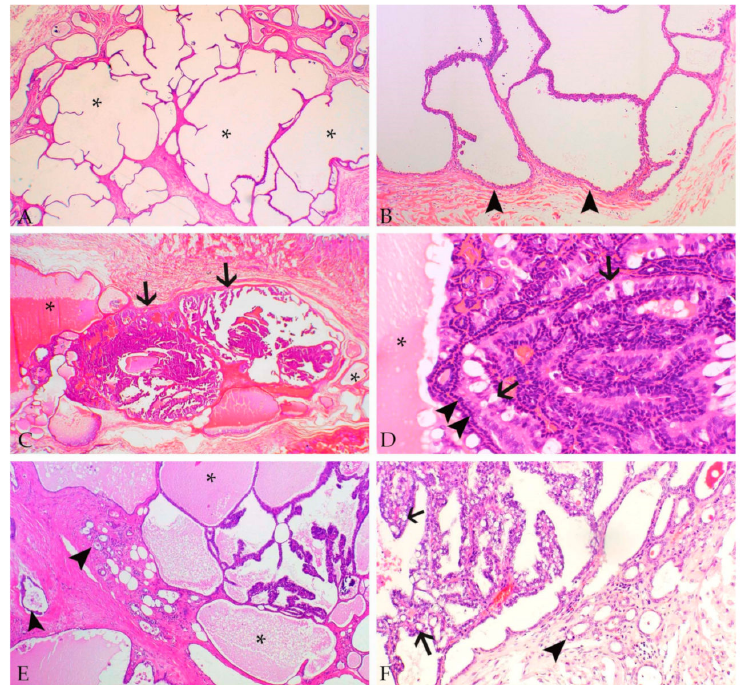
Figure 1. Microscopic images from rabbit mammary gland lesions (hematoxylin–eosin stain). ( A ) Multiple non-neoplastic mammary cysts (asterisks). ( B ) Cystadenoma surrounded by a thin fibrous connective tissue capsule (arrowheads). ( C ) Mammary gland with the concurrent presence of cysts containing proteinaceous secretion (asterisks) and an intraductal papillary carcinoma (arrows). ( D ) Tubulopapillary structures of the in situ carcinoma are lined by a continuous outer layer of ME cells (arrowheads) and an inner layer of neoplastic epithelial cells, some of these containing lipid droplets (arrows). The secretory material in the cystic space is indicated by an asterisk. ( E ) Tubulopapillary and cystic adenocarcinoma with secretory activity (asterisks) and moderate invasive growth in the stroma (arrowheads). ( F ) Tubulopapillary adenocarcinoma with numerous lipid droplets in tumor cells (arrows) and moderate invasive growth in the stroma